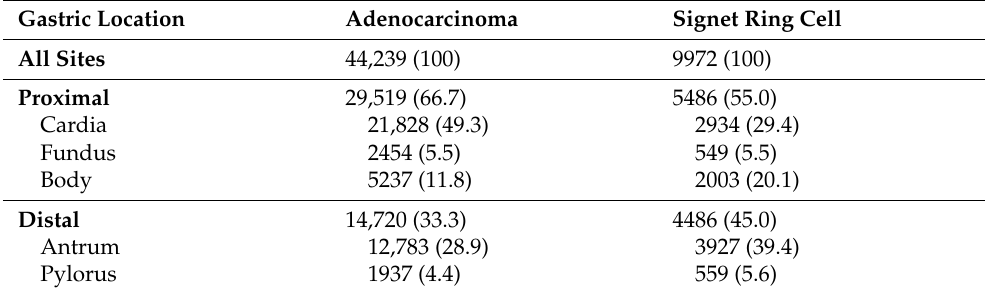
Table 1. Distribution of gastric cancer by